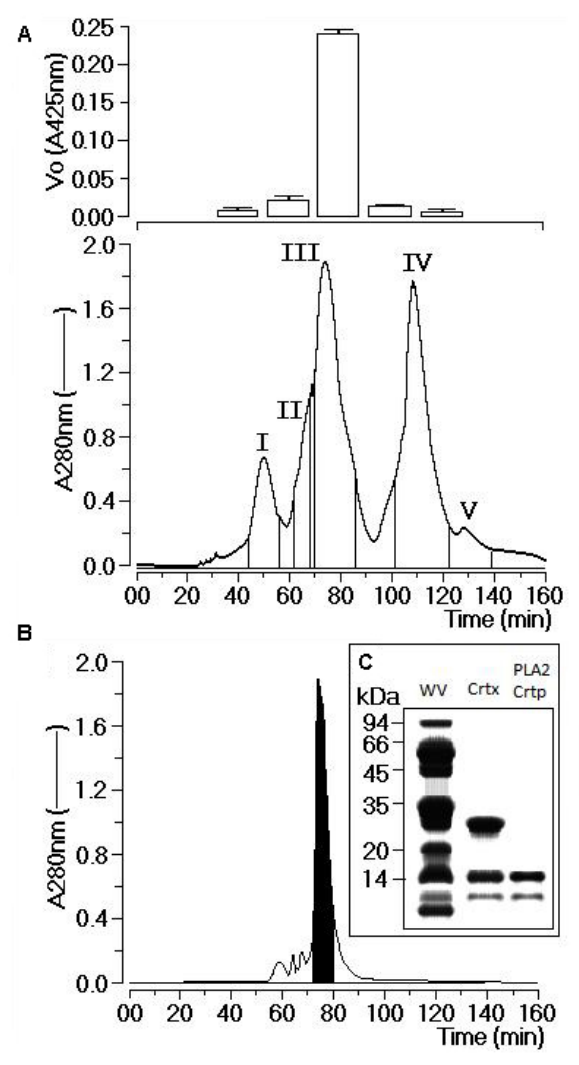
Figure 1 . ( A ) The fractionation of whole venom, which is injected onto the molecular size exclusion HPLC column. The chromatographic run was monitored at 280 nm and aliquots of the main fraction were collected to monitor enzymatic activity. Under this condition, we found that fraction III showed the main PLA activity. The fractions I, 2 II and IV were identified as convulxin, gyroxin and crotamine, respectively. ( B ) The purification of crotoxin fraction from the fraction III, the highly purified crotoxin appears as the black peak. ( C ) The electrophoretic profile of whole venom (WV), highly purified native crotoxin and crotoxin after reduction with 1 M